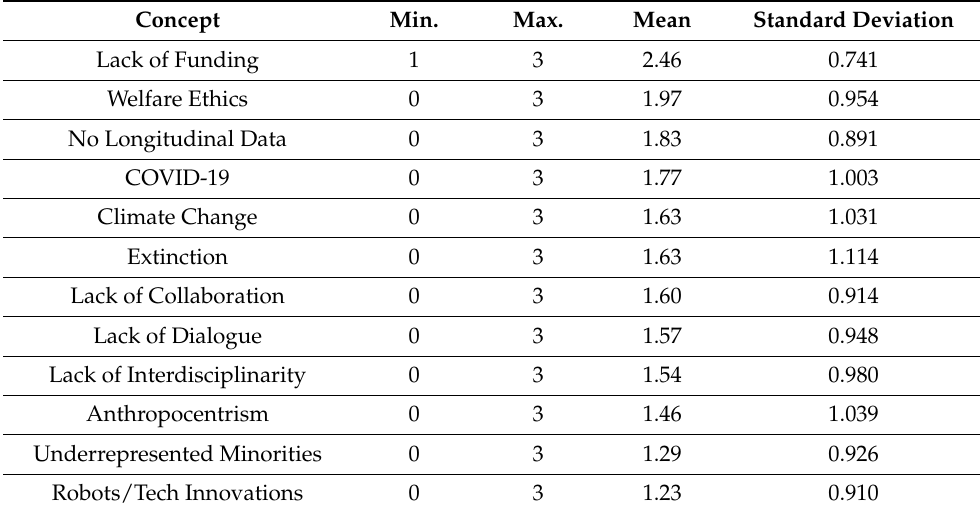
Table 5. Level of impact that twelve events (obtained from qualitative responses in a previous survey, N = 53) may have in our discipline, according to researchers’ opinion ( N =